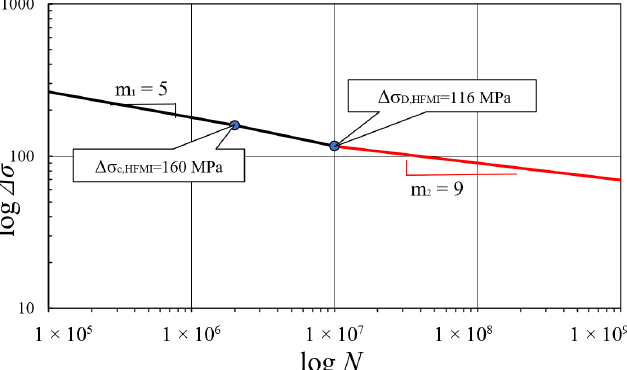
Figure 21. Characteristic S–N curve of the S690 HFMI-treated transverse attachment according to the IIW recommendations [1] and used in the worked